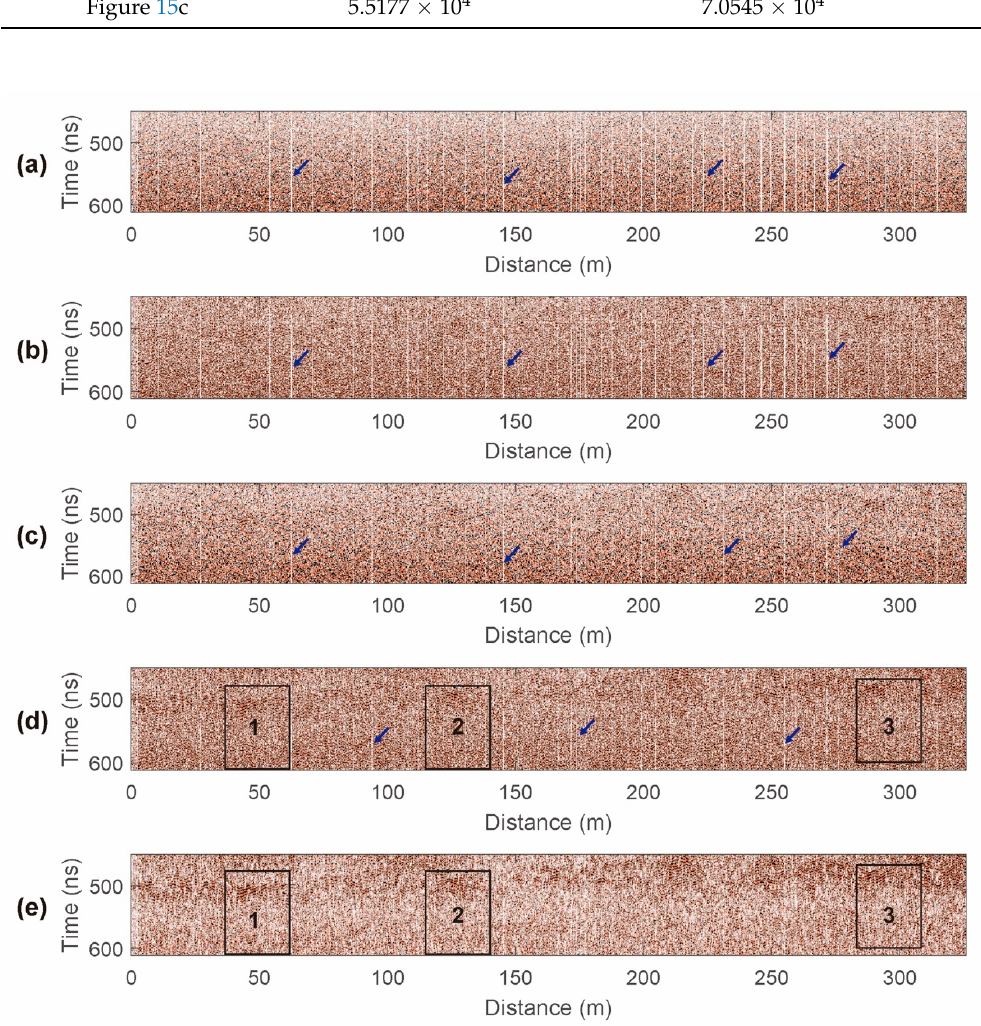
Figure 14. Comparisons of radar profiles below 450 ns (depth below ~35 m). ( a ) Original radargram with no filtering processing. ( b ) Radargram after mean filtering. ( c ) Radargram after band-pass filtering. ( d ) Radargram after the combined method of band-pass and mean filtering. ( e ) Radargram after CNN filtering. The blue arrows indicate the strips of interference. The three rectangular regions 1–3 are magnified and presented in Figure 15.